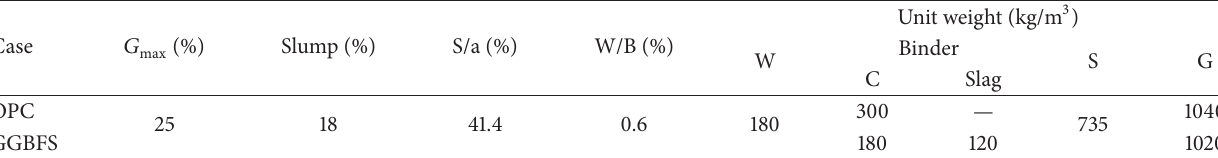
Table 1: Mix proportions for the test.